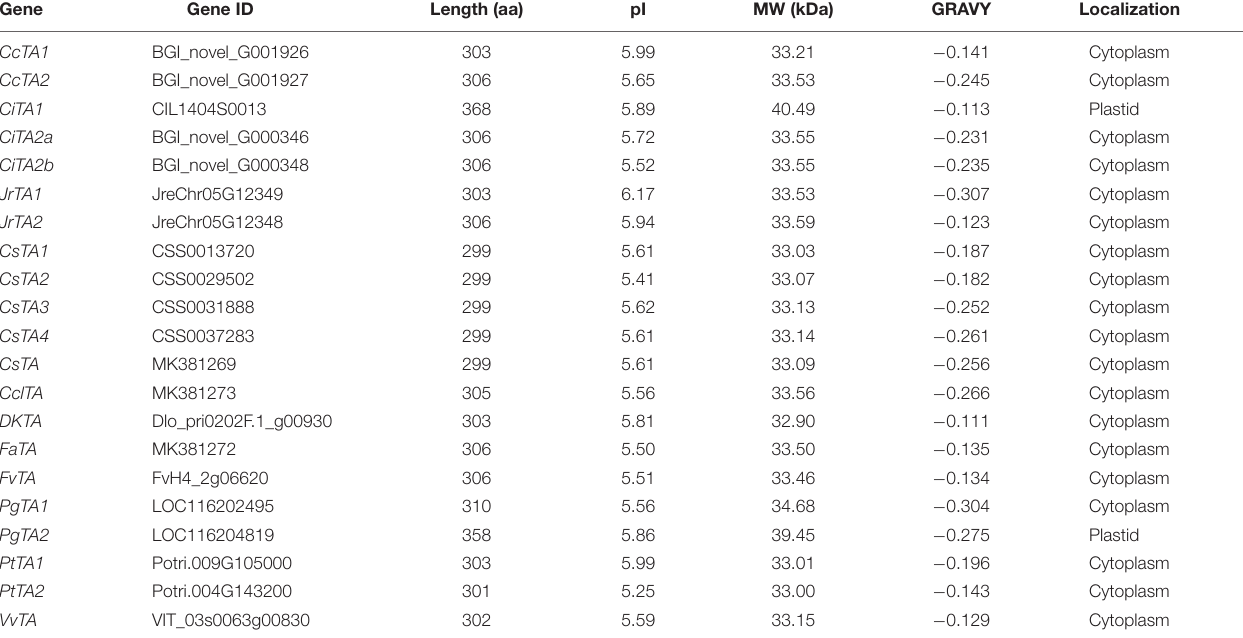
TABLE 1 | Detailed information of plant tannase genes in the Juglandaceae and other land